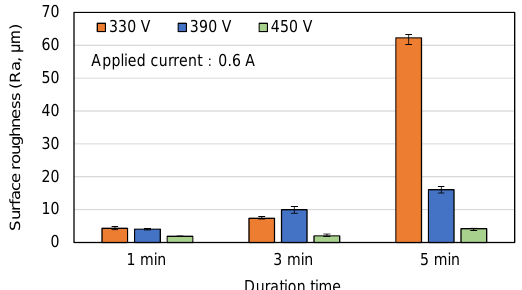
Figure 6. Surface roughness of MAO coatings prepared with different applied voltages and duration times and constant applied current of 0.6 A.